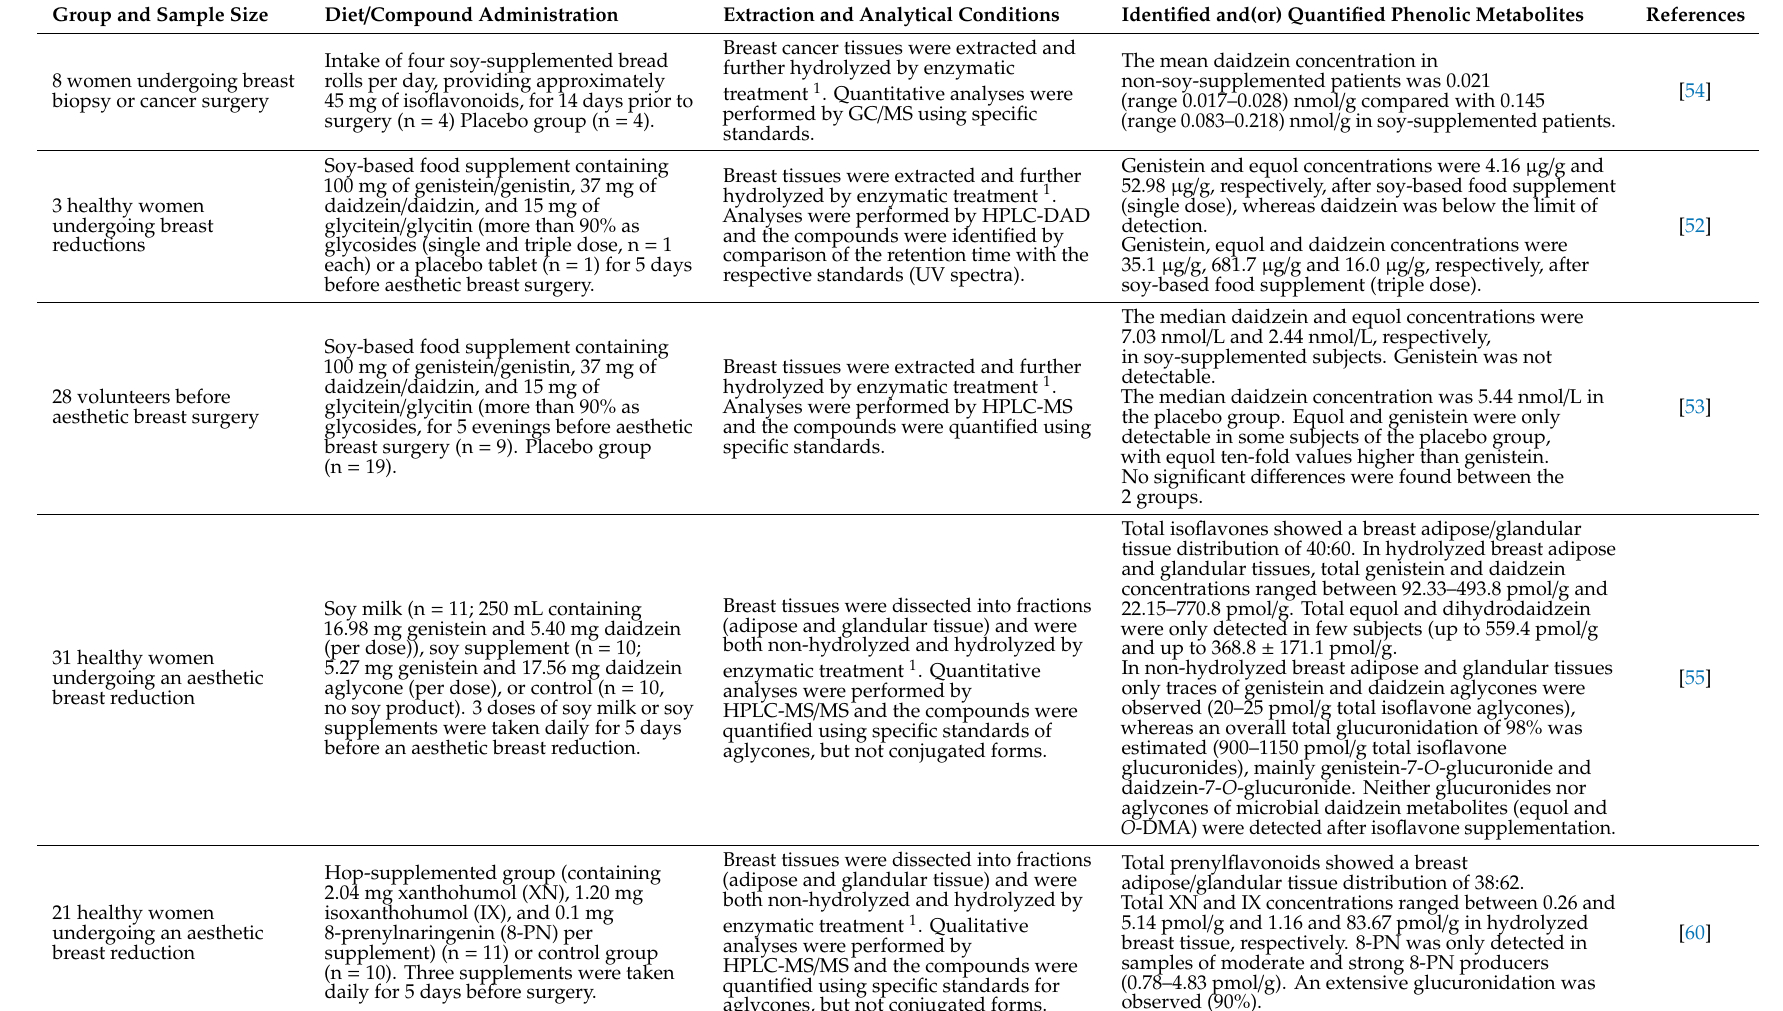
Table 1. Dietary phenolics and derived metabolites identified in human breast